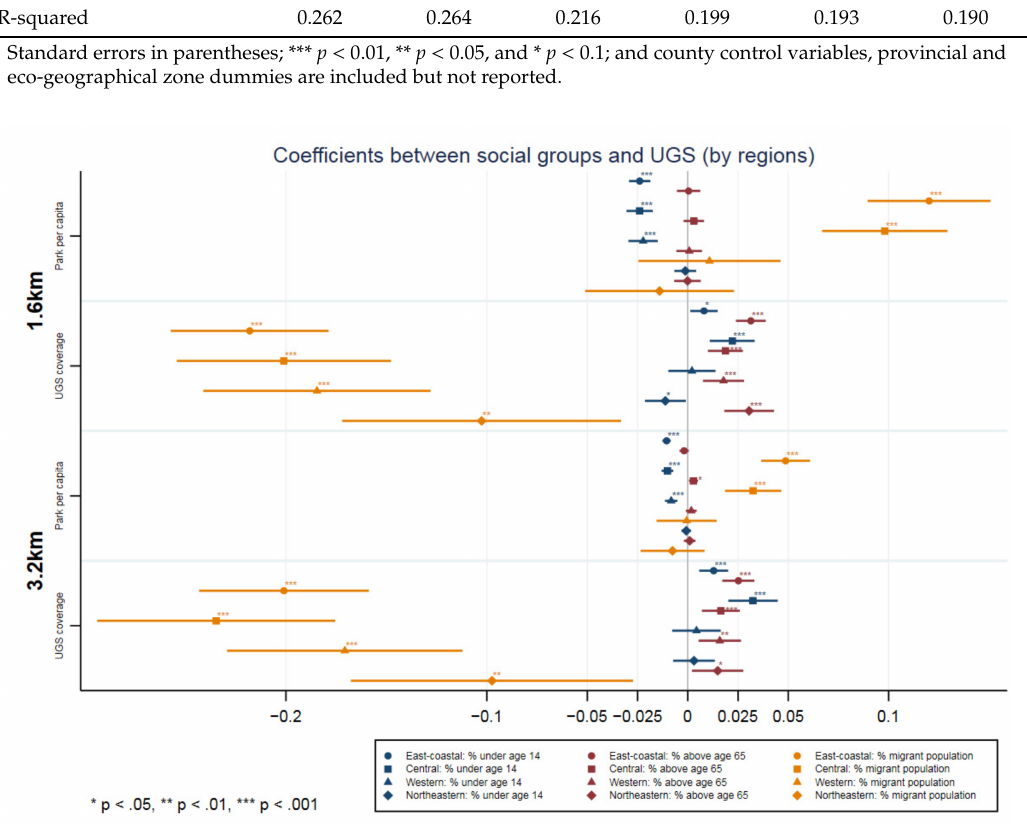
Figure 6. Coe ffi cients between di ff erent social groups and urban green space distributions by in four